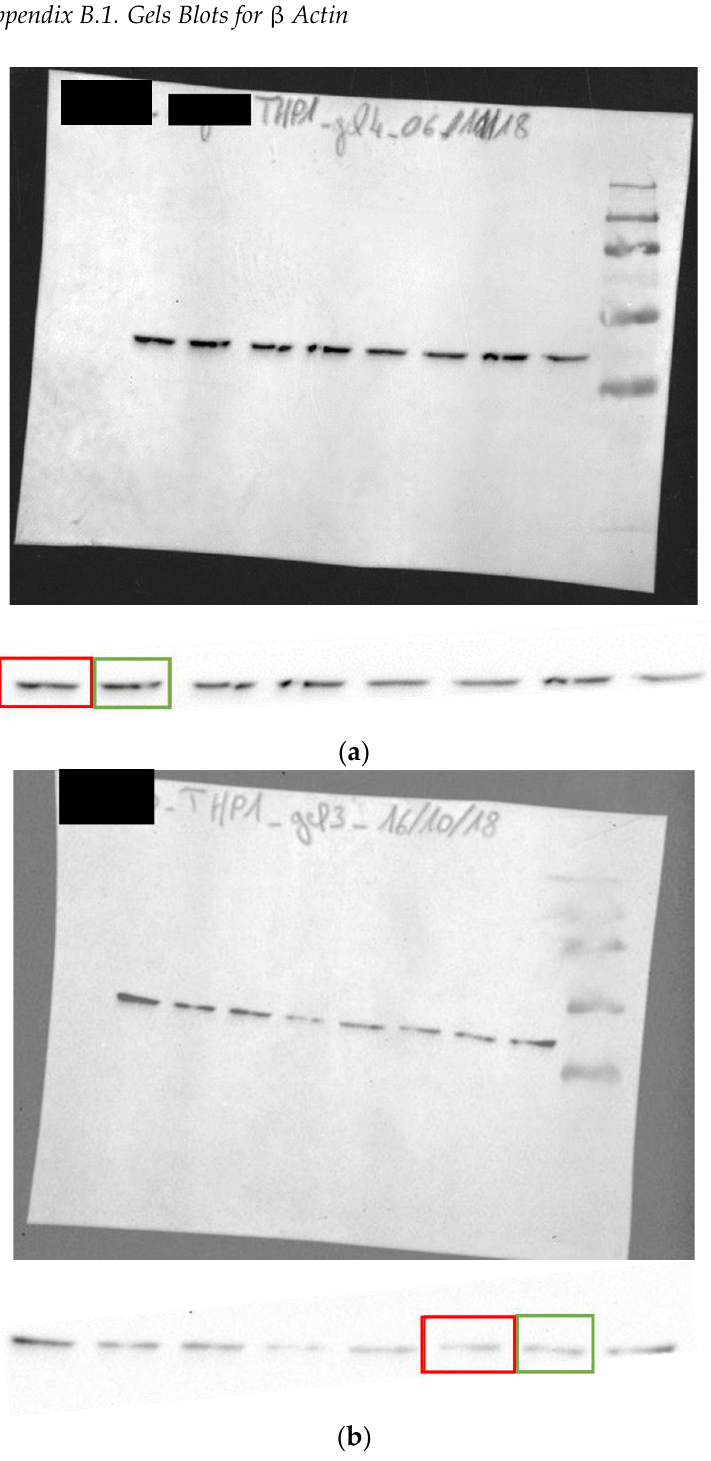
Figure A3. Gels blots for β Actin. ( a ) β Actin in THP -1 incubated with LPS (1 µg/mL) ( b ) β Actin in THP-1, without LPS. Red squares: Control, Green squares : with LS-E (50 µg/mL).